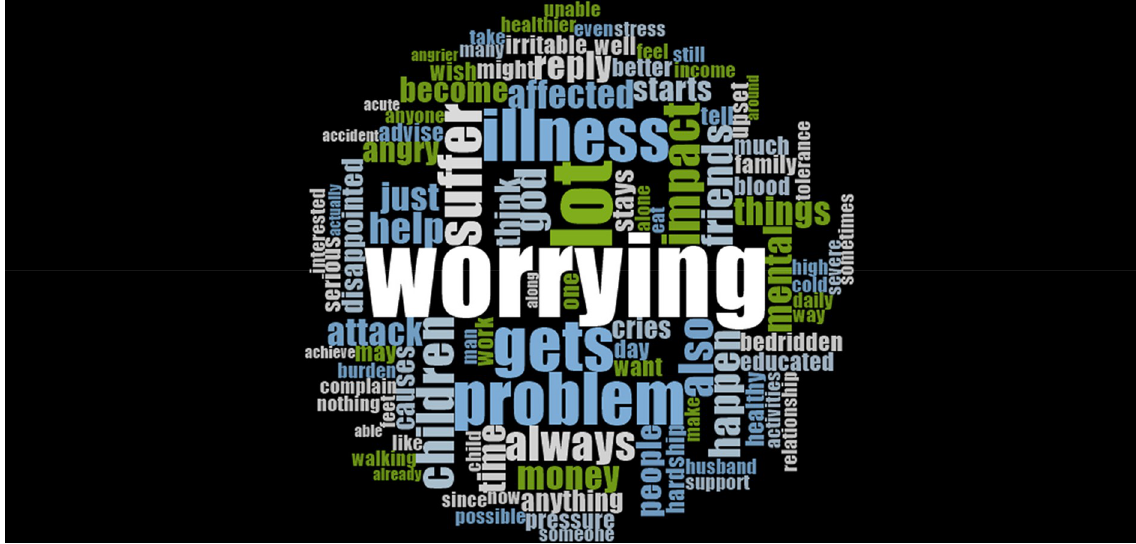
Fig 2. Word cloud of terms used by caregivers in relation to the theme of emotional